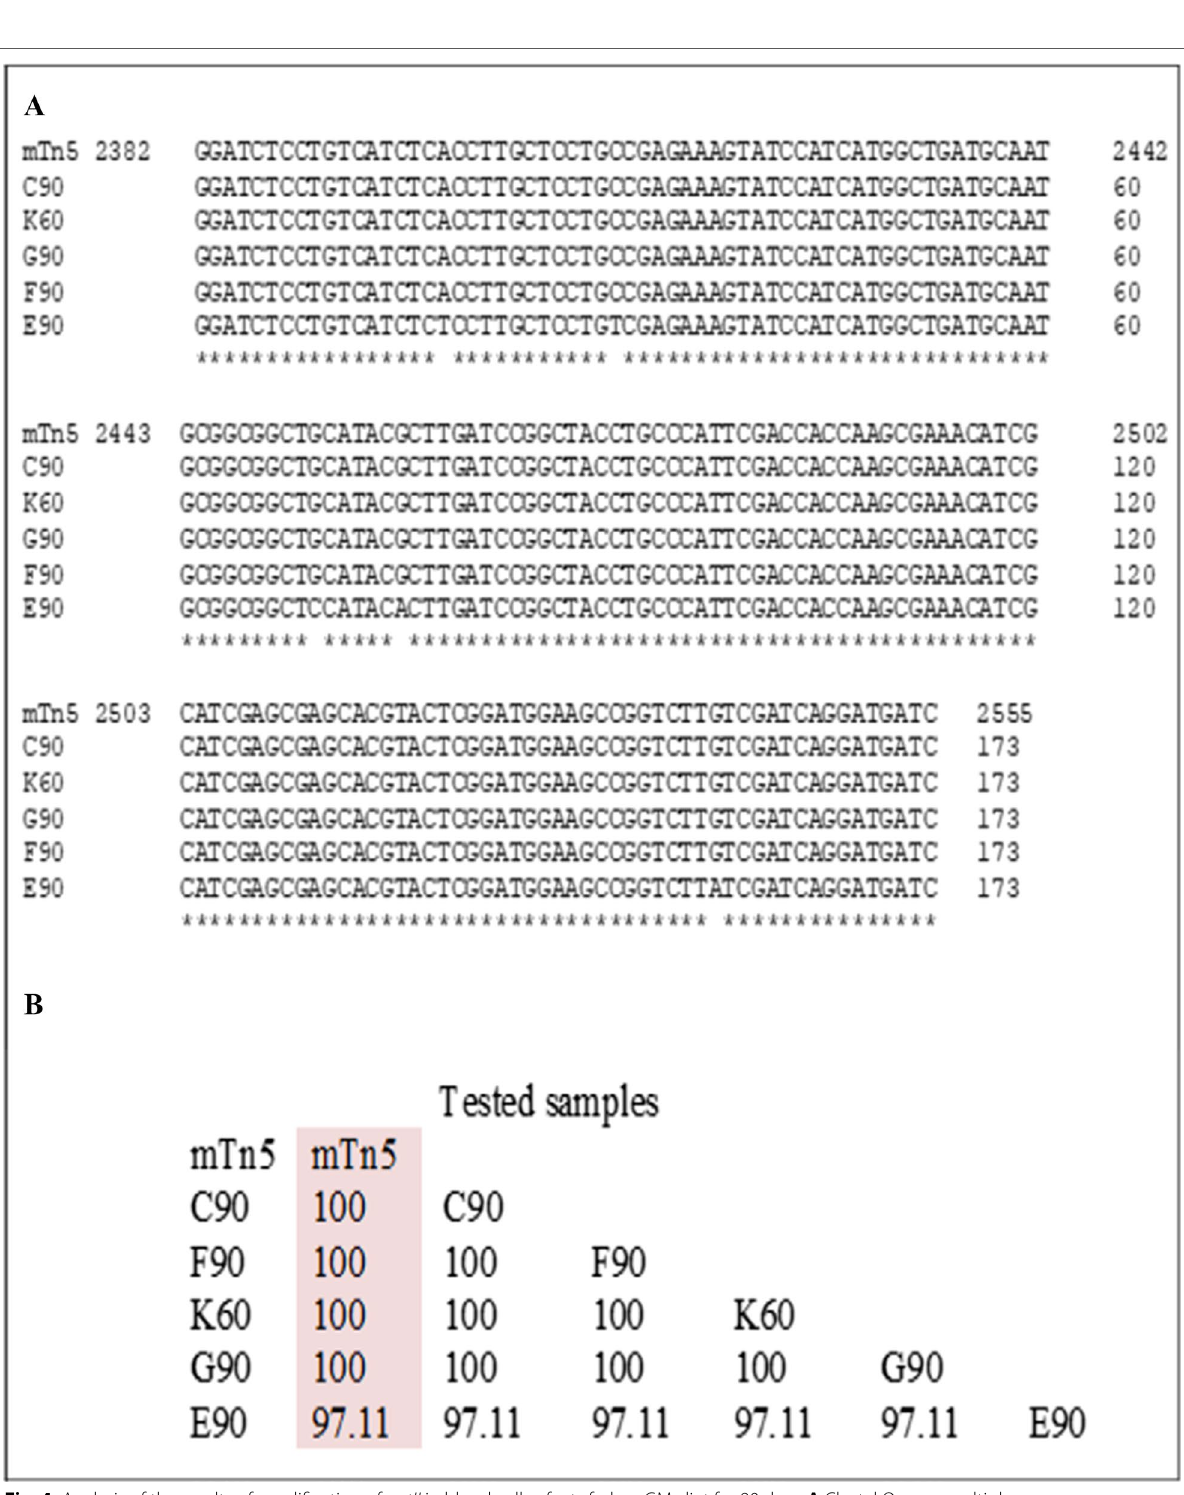
Fig. 4 Analysis of the results of amplification of nptII in blood cells of rats fed on GM‑diet for 90 days. A Clustal Omega multiple sequence alignment of the internal nucleotide sequences of a number of blood samples along with the corresponding segment from the reference sequence mTn5 (AF080390.1). B Percent Identity Matrix—created by Clustal2.1—for the internal nucleotide sequences of the PCR amplicon (C90, F90, K60, G90 and E90) obtained from the amplification of primers for NPTII gene. mTn5 is the original sequence of the corresponding segment of mTn5